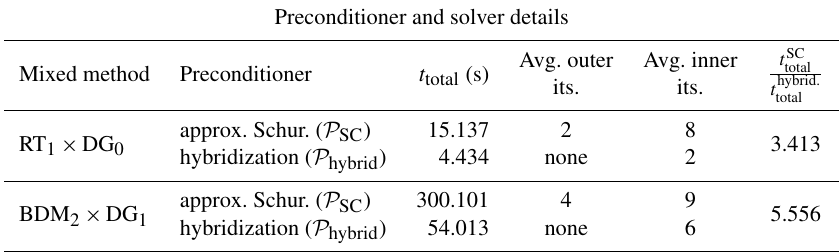
Table 3. Preconditioner solve times for a 25-step run with (cid:49)t = 100s. These are cumulative times in each stage of the two preconditioners throughout the entire profile run. We display the average iteration count (rounded to the nearest integer) for both the outer and the inner Krylov solvers. The significant speedup when using hybridization is a direct result of eliminating the outermost solver.